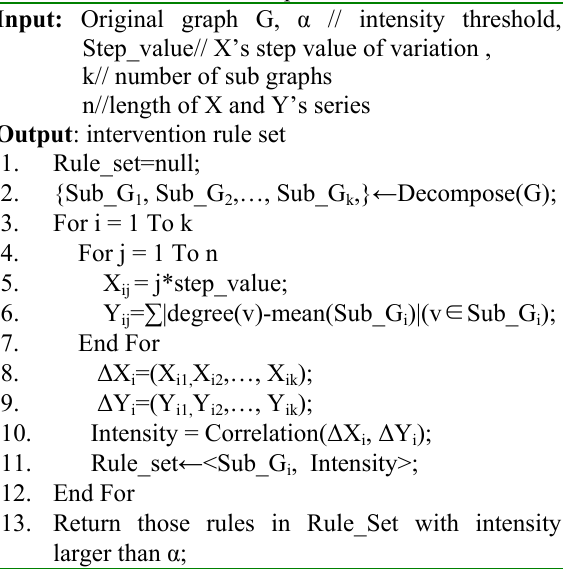
Algorithm 2(MMIRCN) : M ining M ulti-scale I ntervention R ule from C omplex N etwork